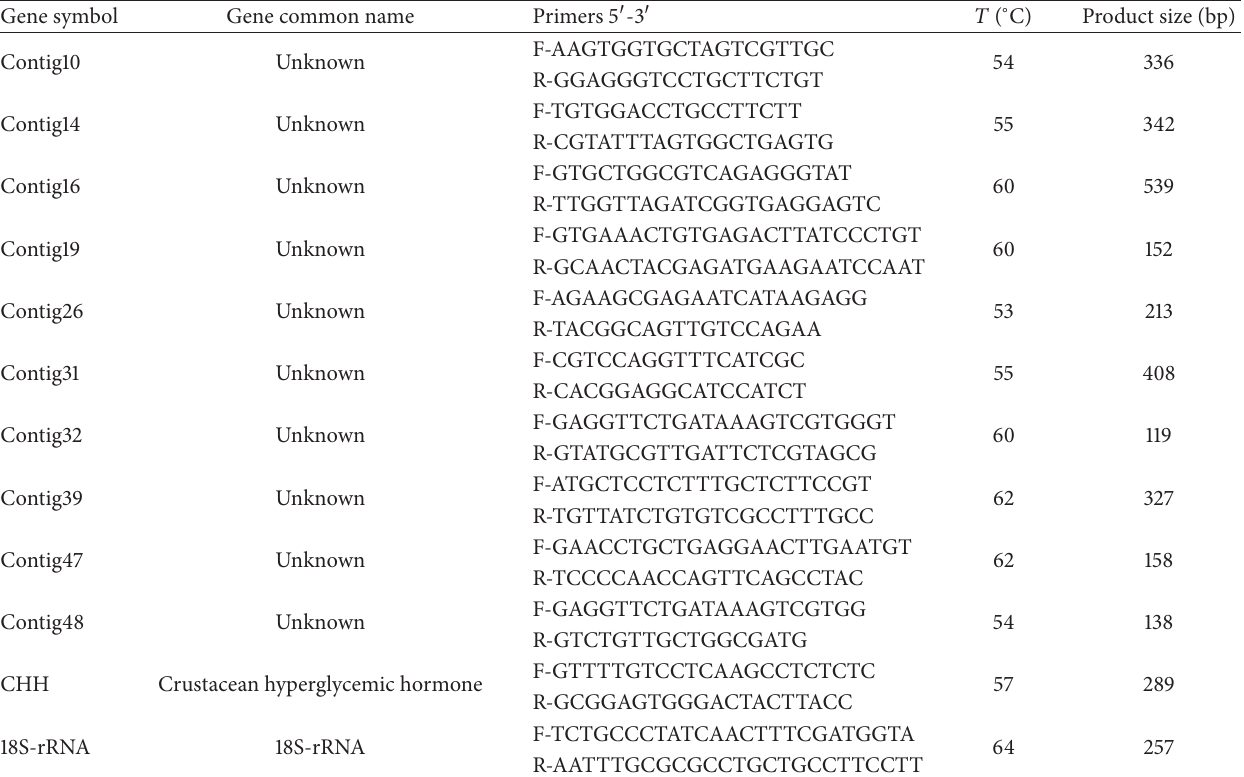
Table 1: List of primers with their information used for